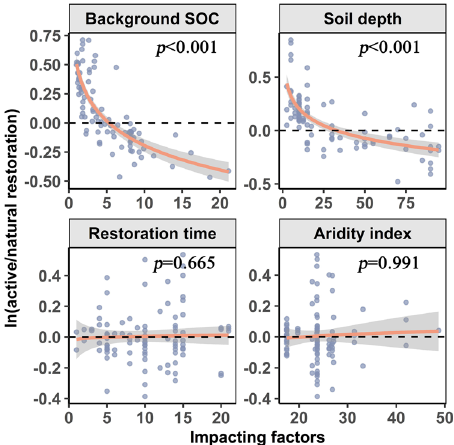
Fig. 3 The difference of carbon sequestration between active and natural grassland restoration along with background SOC, soil depth, restoration time and aridity index across China. If the difference {ln (active/natural)} is above 0, it indicates a greater carbon sequestration by active than natural restoration, or vice versa.